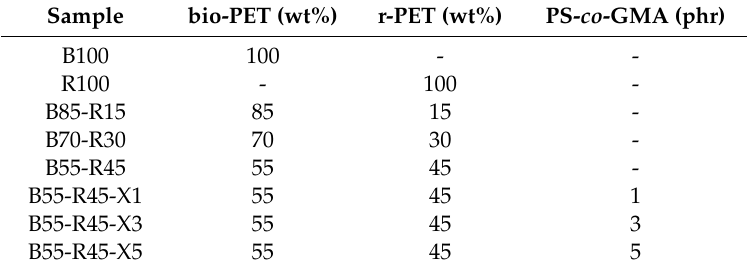
Table 1. Code and composition of each sample according to the weight content of partially bio-based (bio-PET) and recycled polyethylene terephthalate (r-PET) in which poly(styrene- co -glycidyl methacrylate) (PS- co -GMA) was added as parts per hundred resin (phr) of